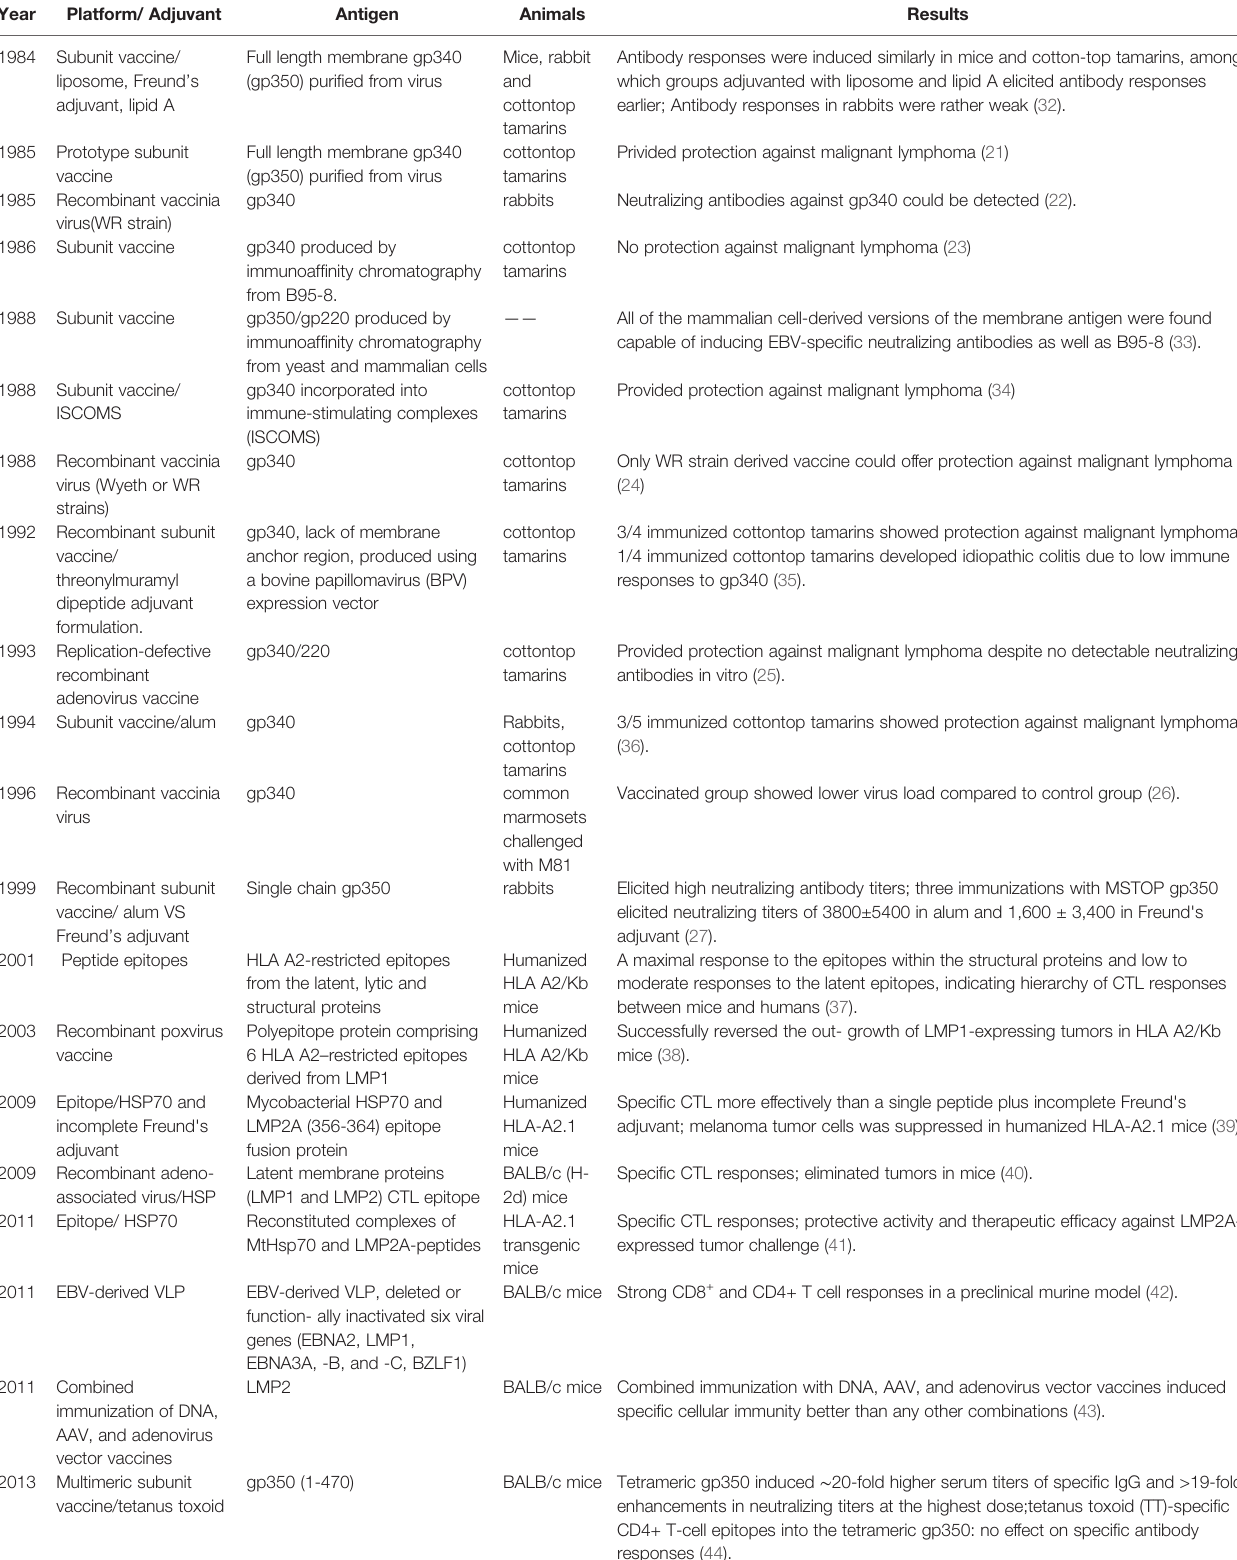
TABLE 1 | Summary of EBV vaccine animal